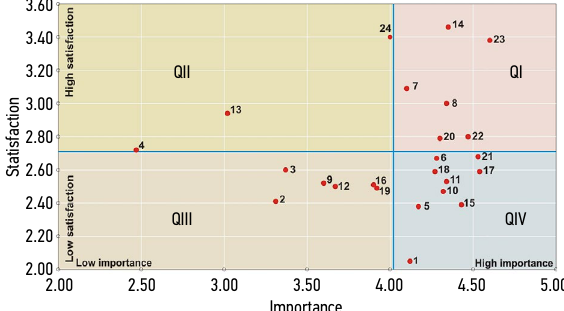
Fig. 2. Service quality elements distributed per quadrants